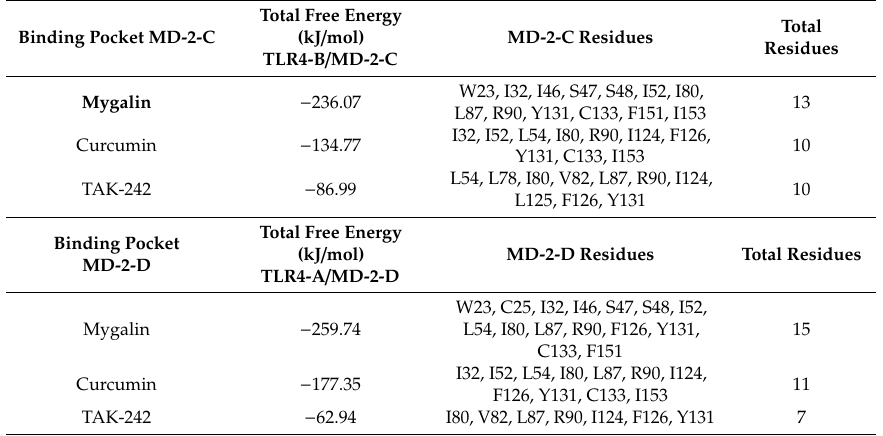
Figure 2. TLR4 / myeloid di ff erentiation factor 2 (MD-2) complexes from the docking study of three ligands. Representative MD-2-D binding pocket of the TLR4 / MD-2 complexes; the same event occurred in MD-2-C. ( a ) TLR4 / MD-2 complexes showed a potential center binding site in MD-2. Mygalin in the MD-2 binding pocket showed no interaction with TLR4 residues. ( b ) Ligands (yellow) upon interaction with MD-2 (blue) residues. Most of the interactions were hydrophobic, although residues R90 and W23 show polar interactions, due to hydrogen bonds. Dotted lines show hydrogen bonds. Interaction energies of the ligands and residues of the binding pocket of the TLR4 / MD-2